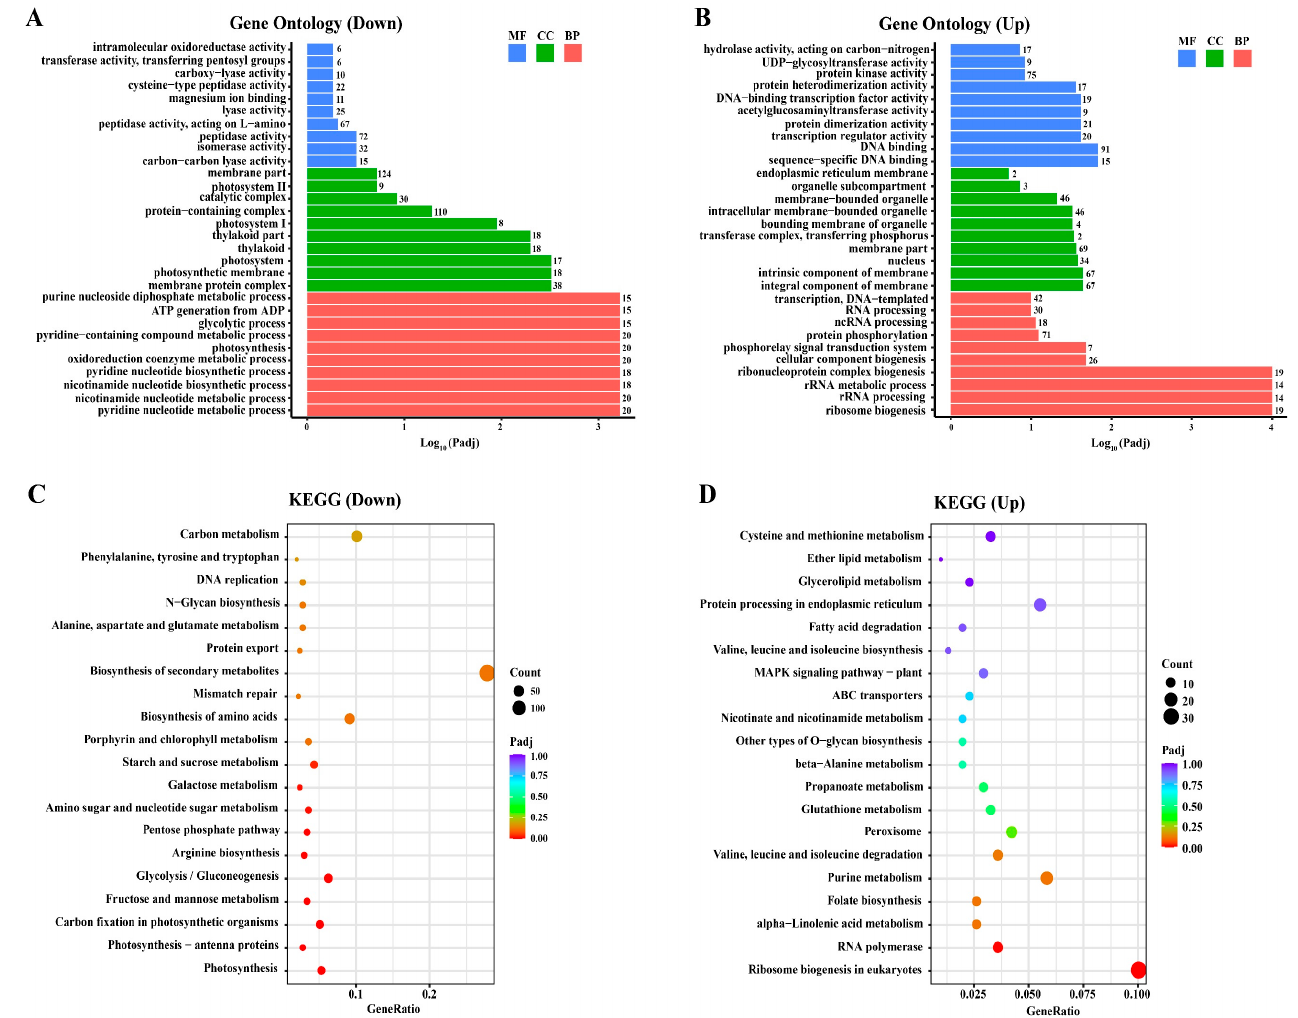
Figure 6. Gene ontology and KEGG pathway enrichment analysis of DEGs. ( A ) Significantly downregulated enriched gene ontology for AZD treatment in the RNA-seq database. ( B ) Significantly upregulated enriched gene ontology for AZD treatment in the RNA-seq database. Gene ontology was ranked by their significance. The value represents the number of differentially expressed genes. MF, molecular function; CC, cellular component; BP, biological process. ( C ) The top 20 functionally enriched KEGG pathways in downregulated DEGs. ( D ) The top 20 functionally enriched KEGG pathways in upregulated DEGs.